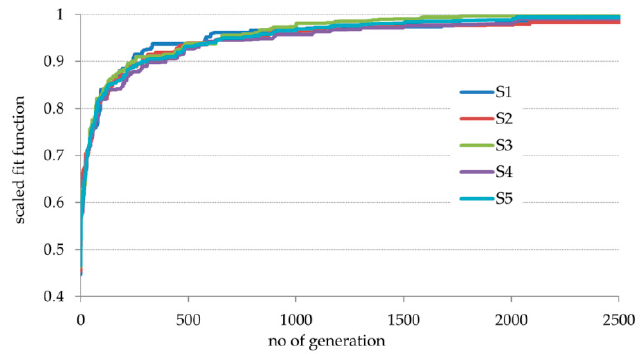
Figure 6. Examples of obtained stations layouts.